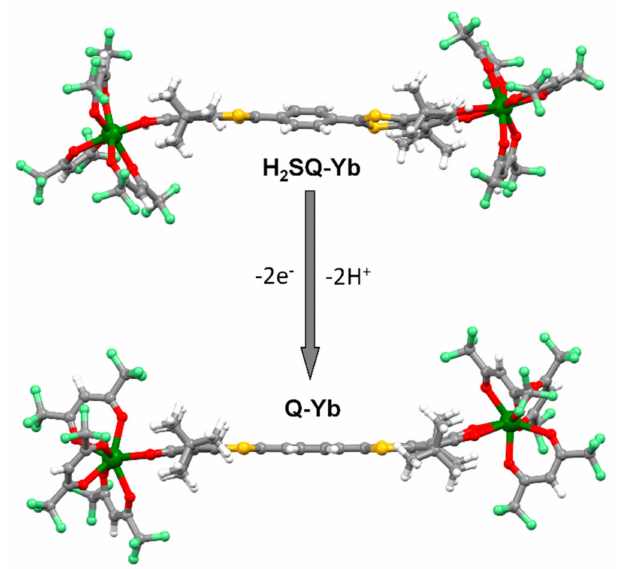
Figure 1. Experimental molecular structure of H 2 SQ-Yb and DFT optimized structure of its oxidized form Q-Yb . Molecules of crystallization are omitted for